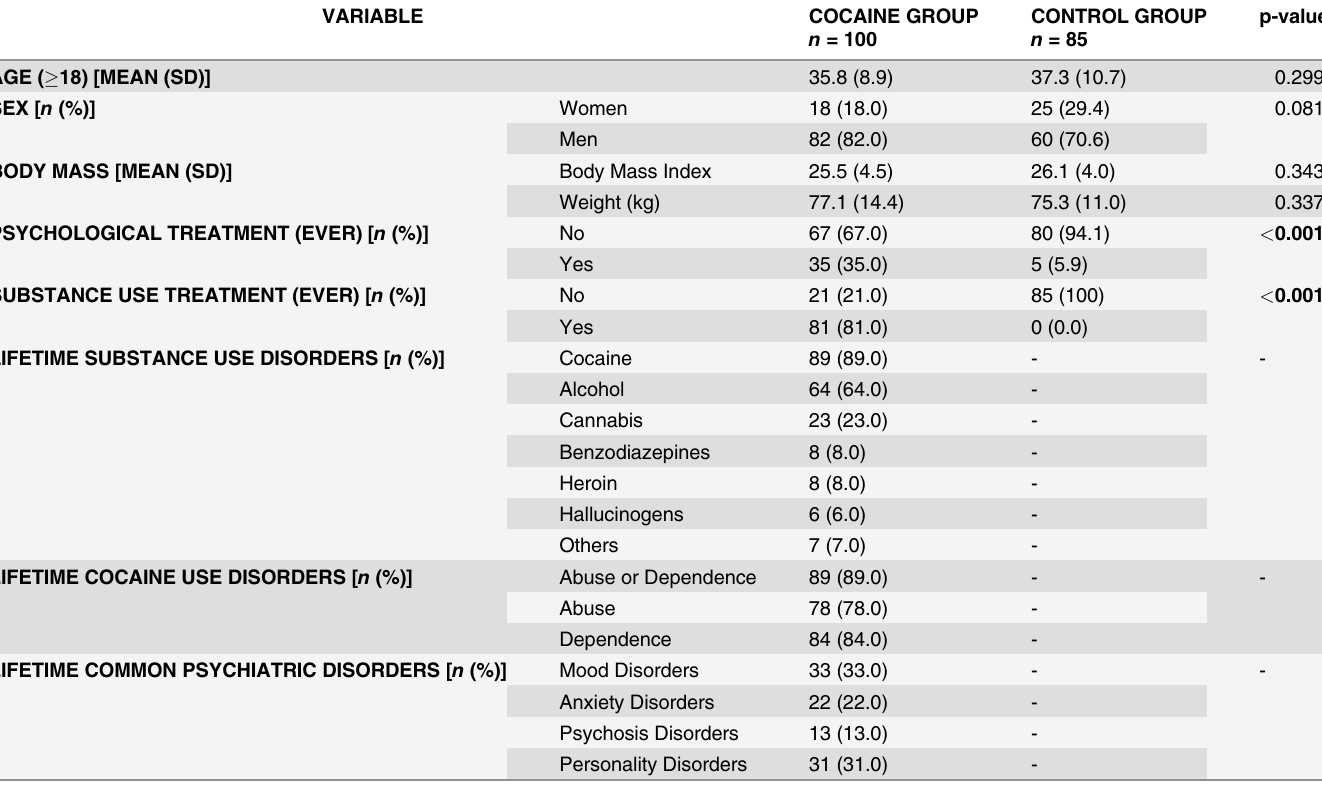
Table 1. Baseline socio-demographic variables and lifetime psychiatric and substance use